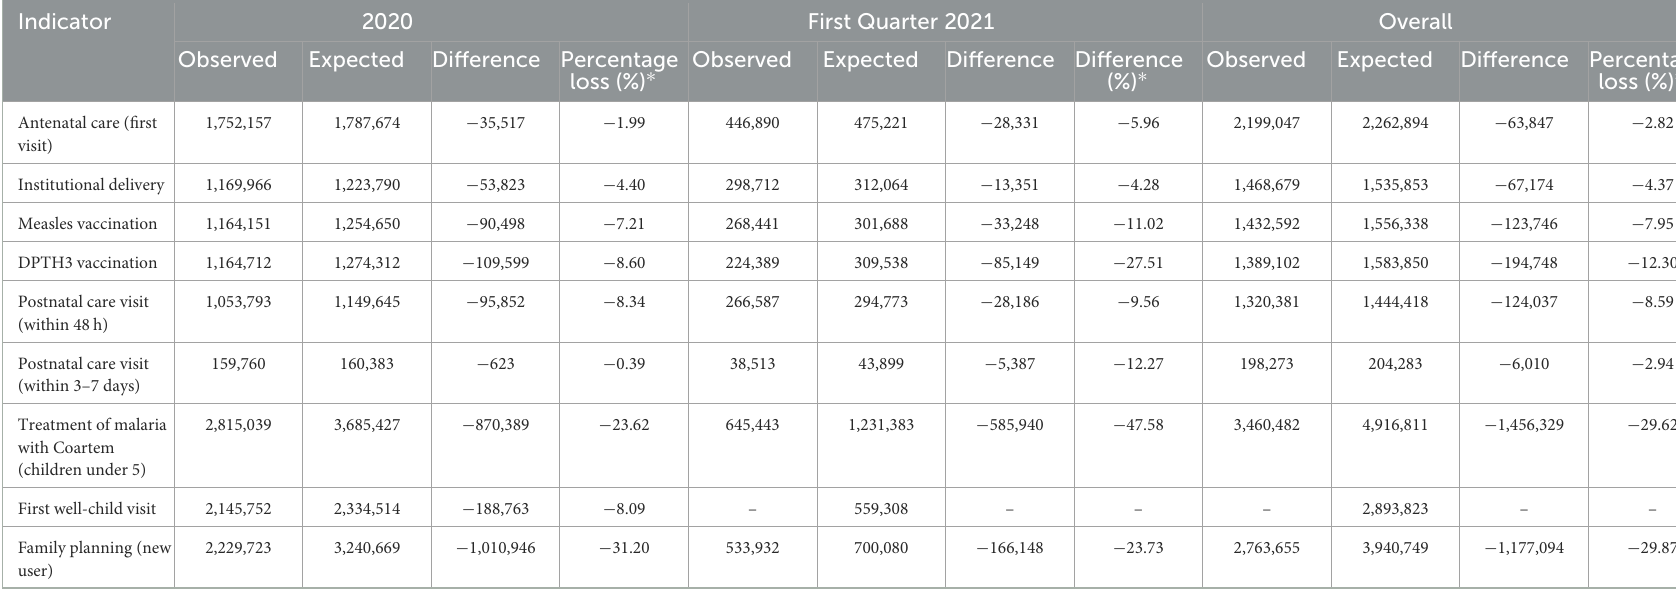
TABLE 4 Mozambique observed and expected service losses by indicator, 2020 and first quarter of 2021.